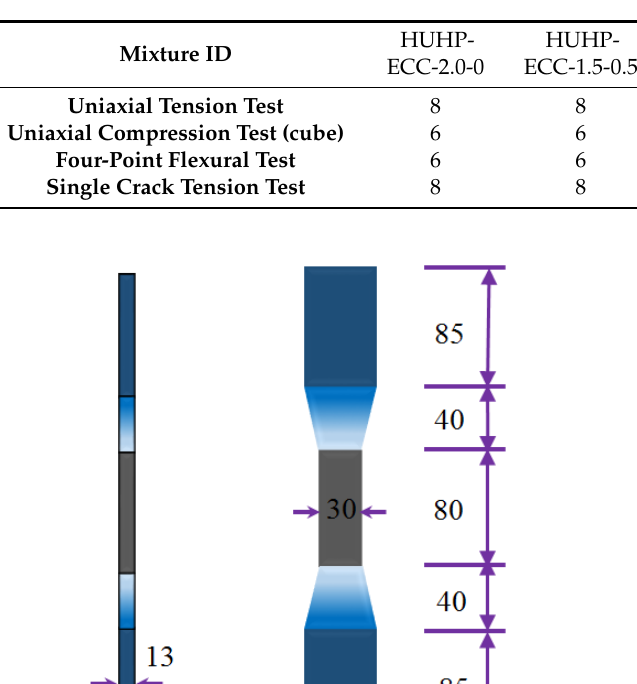
Table 4. Numbers of replicate specimens in each test.